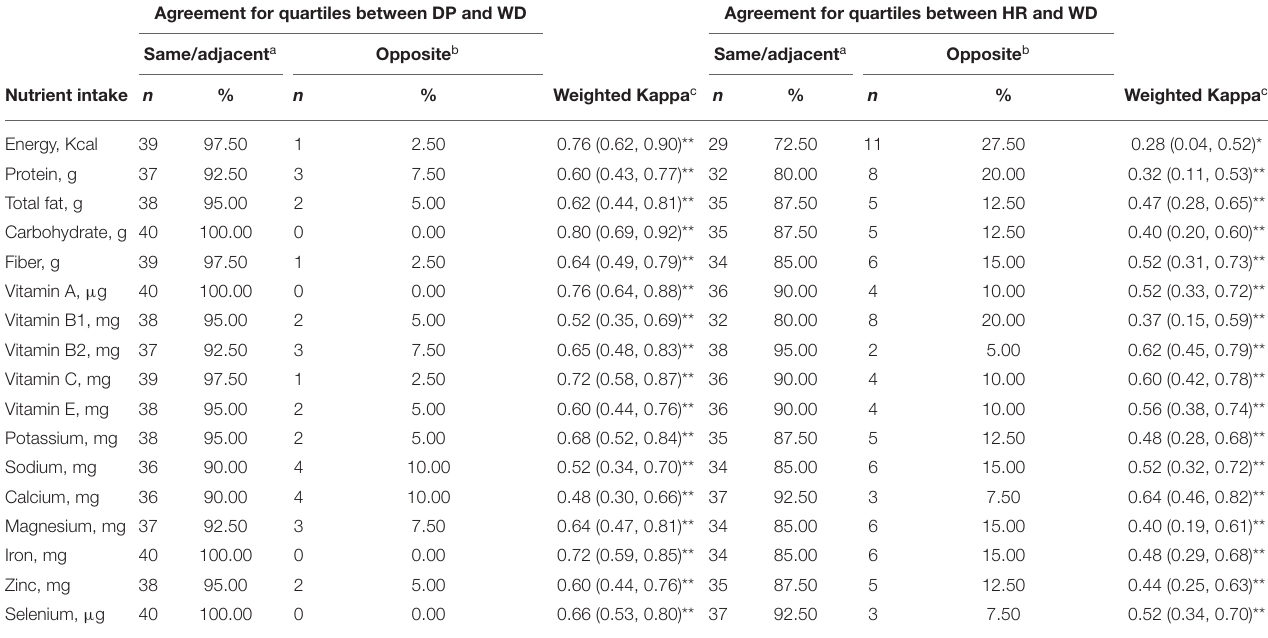
TABLE 2 | Cross-classification for agreement among the daily intakes of energy and nutrients recorded in 24h dietary recall (HR), diet photograph record (DP), and weighed dietary record (WD) in the preschoolers from Southwest China ( n = 40). Agreement for quartiles between DP and